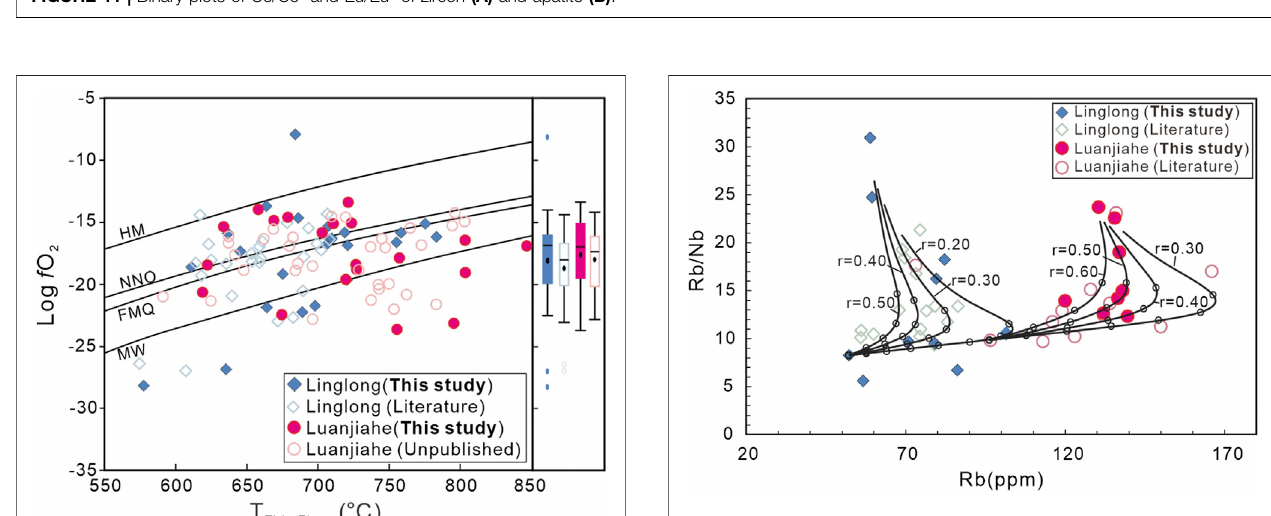
FIGURE 11 | Binary plots of Ce/Ce* and Eu/Eu* of zircon (A) and apatite (B) .